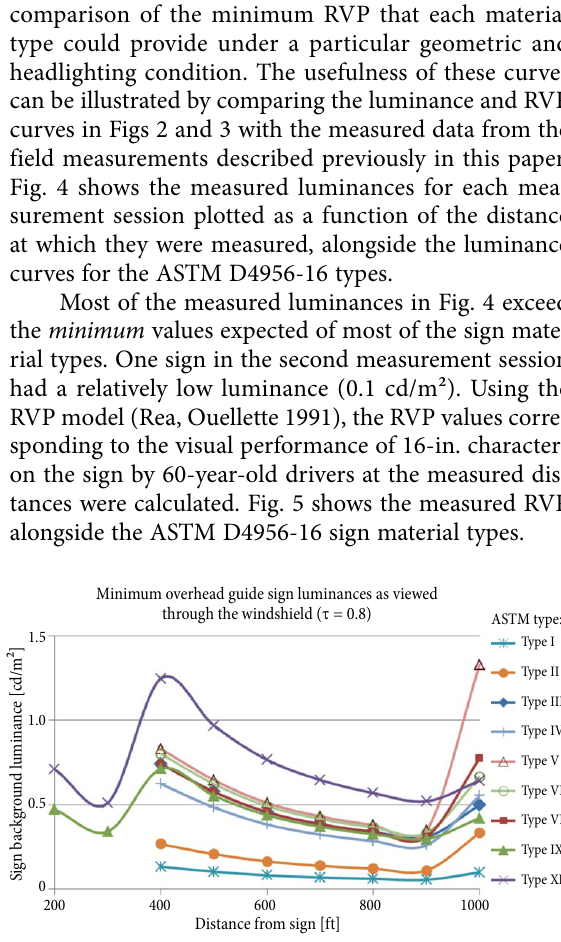
Fig. 2. Minimum overhead sign luminance, as a function of distance from the sign, for each of the ASTM D4956-16 sheeting